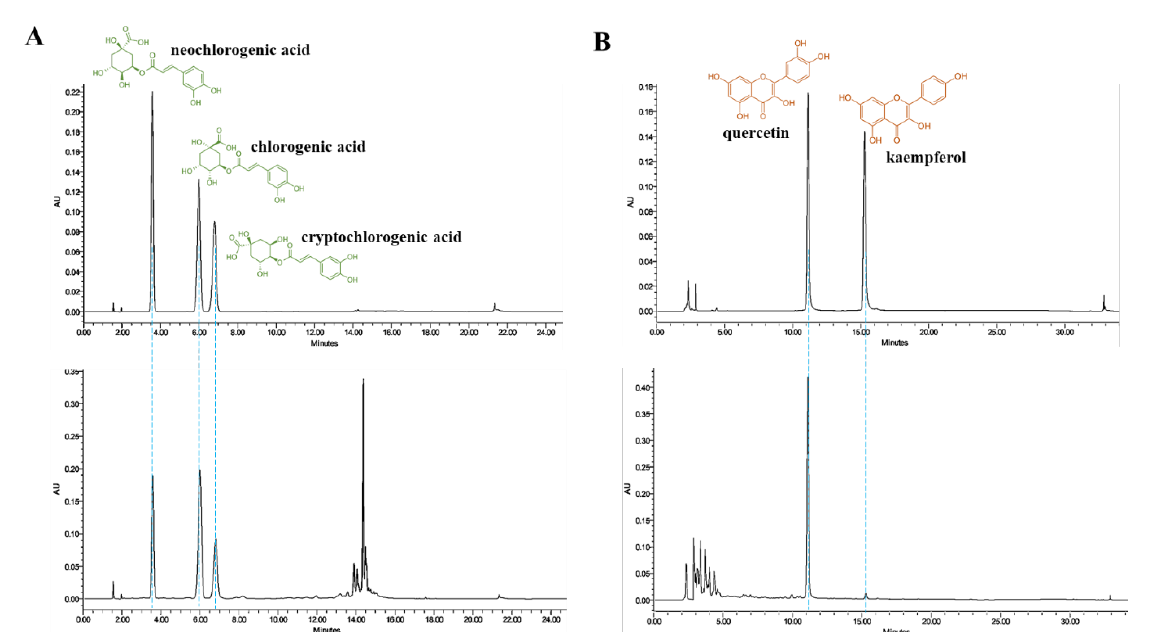
Figure 2. The high-performance liquid chromatography (HPLC) profiles of D. morbiferus H. Lév. leaf extract (DPL). ( A ) Column: XDB-C 18 ; solvent system for neochlorogenic acid, chlorogenic acid, and cryptochlorogenic acid, a gradient system from 10:90 to 0:100 of acetonitrile with phosphoric acid, 0 – 25 min was used. ( B ) Column: PhenoSphere™ 5 μm ODS (2); solvent system for quercetin and kaempferol, a gradient system with trifluoroacetic acid/water with acetonitrile as follows: 0 – 2 min, 80:20; 2 – 25 min 55:45; 25 – 30 min, 0:100; 30 – 31 min, 80:20. The flow rate was 1 mL/min, and for detection, a diode-array detector (DAD) at 370 nm was used. Quantitative HPLC analysis was replicated three times.